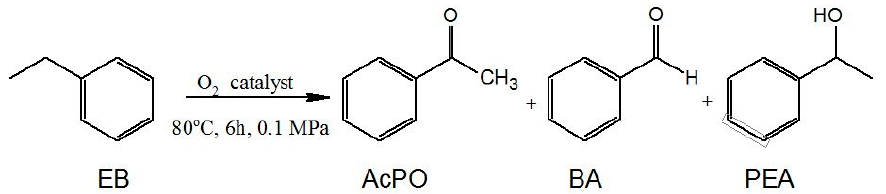
Figure 4. The ethylbenzene oxidation reaction.